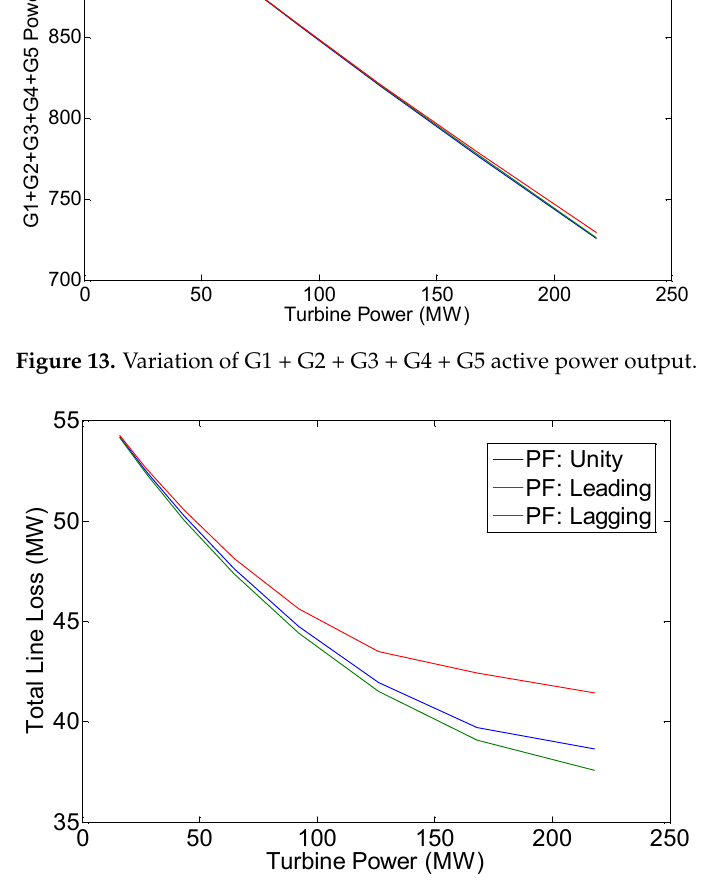
Figure 14. Variation of total line loss.